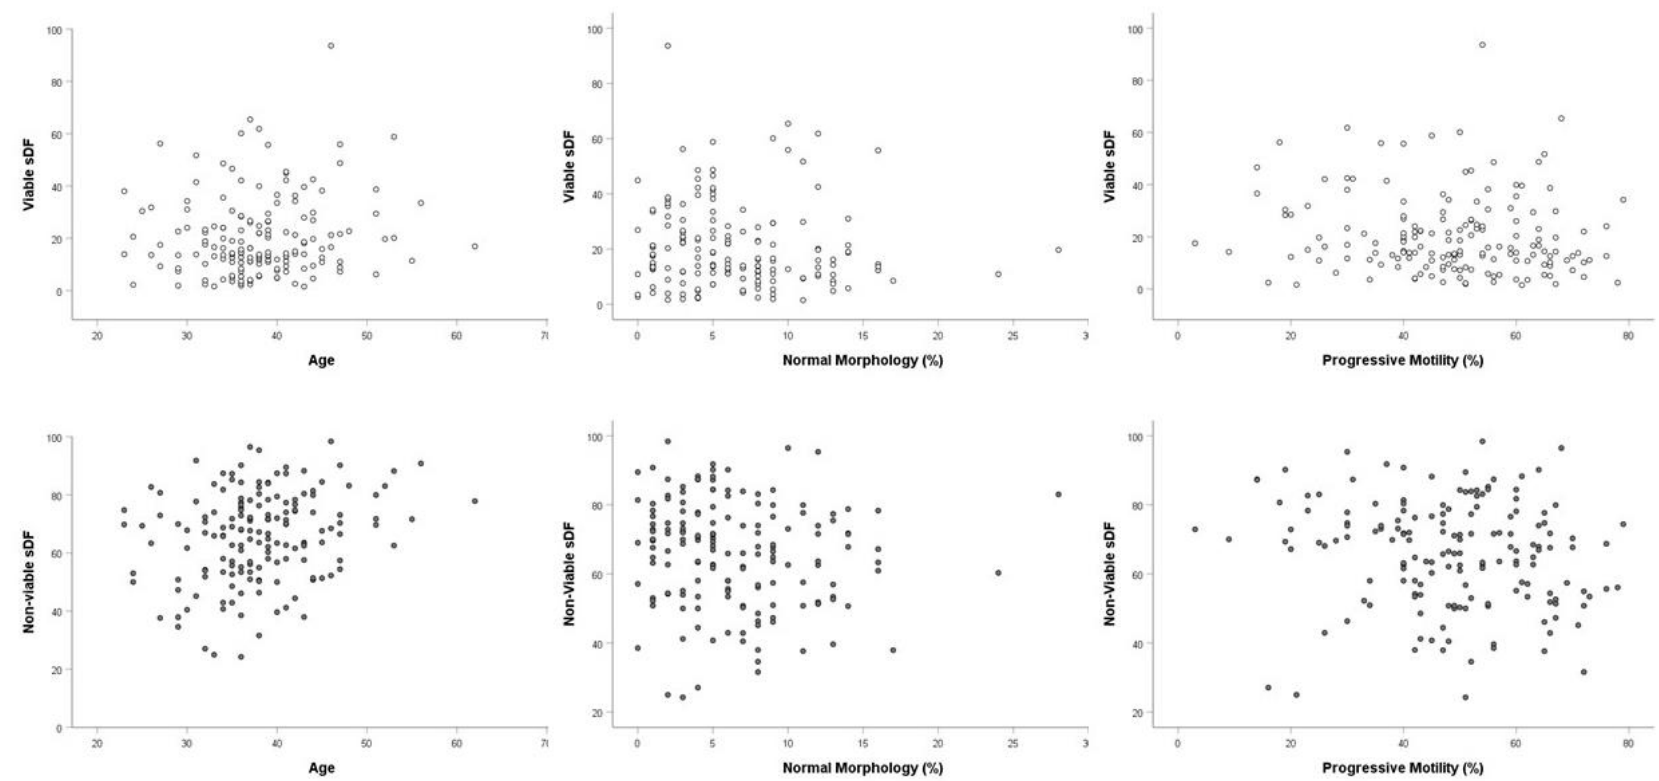
Figure 3. Relationship between sDF and semen quality and age. Dispersion plots reporting viable sDF (upper panels) and non-viable sDF (lower panels) against age, sperm morphology, and progressive motility as found in the 162 recruited subjects (91 patients and 71 fertile men).